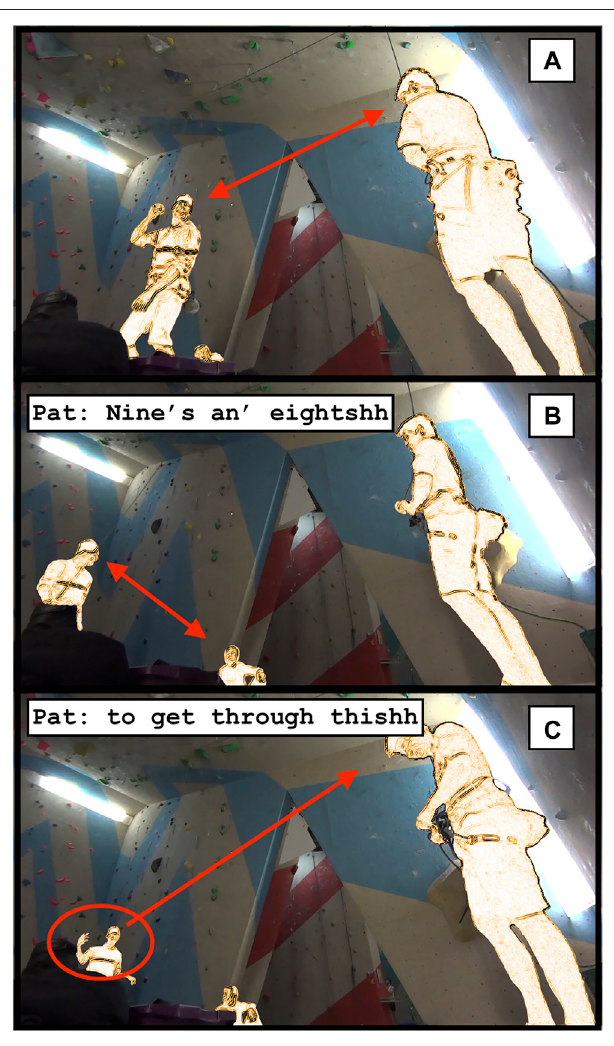
FIGURE 5 | Pat (on the left) gazes at Eric (on the right) while getting his balance, potentially recruiting Eric to help him complete the phrase he started (line 3). Instead, Pat (re)completes the phrase himself (lines 8 –